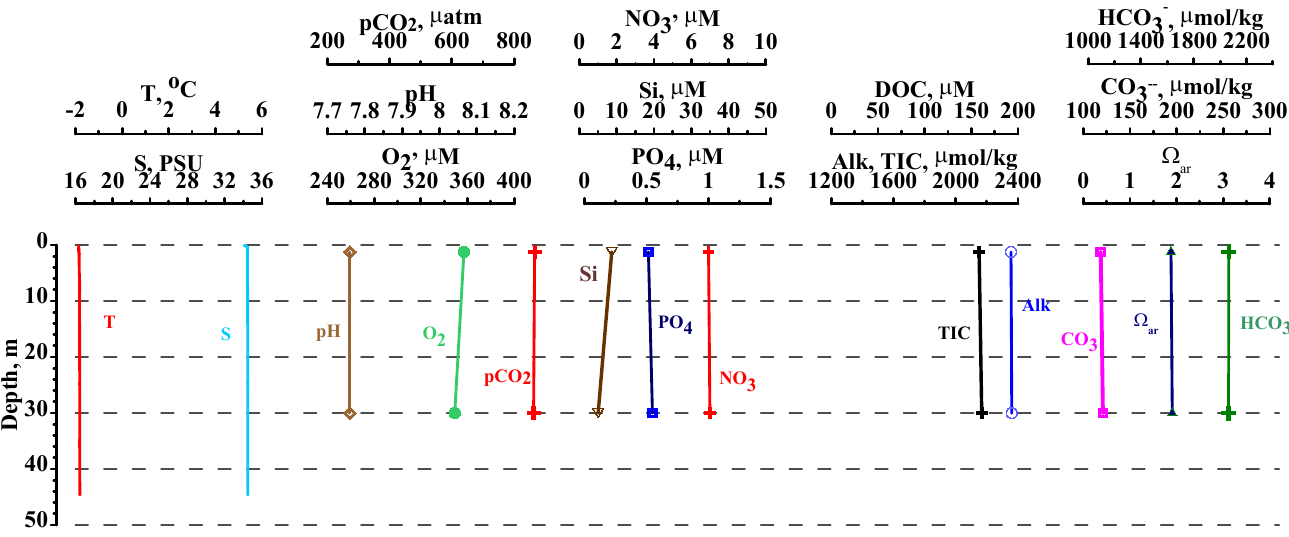
Figure A2. Vertical distribution of physical and chemical parameters at station T5 (19 February